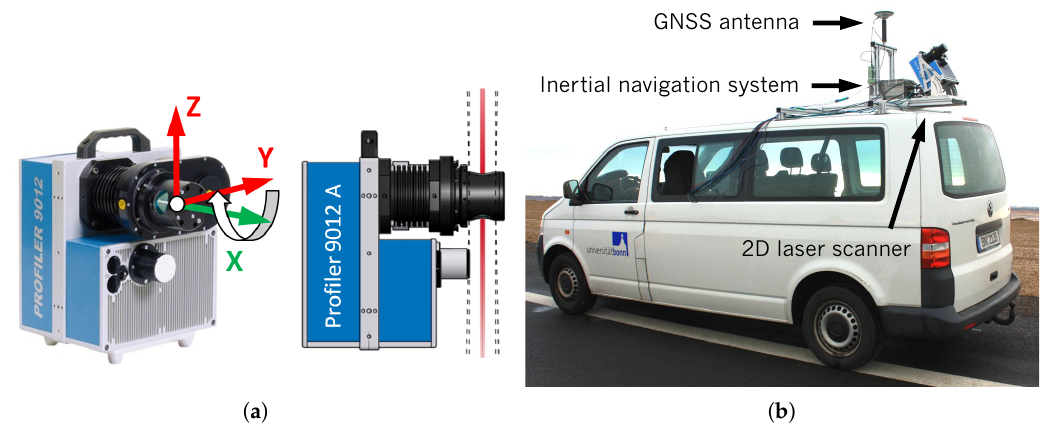
Figure 1. ( a ) Z + F Profiler 9012A with 2D scanning profile in red (YZ-plane) and rotational axis of the deflecting mirror in green (X-axis) [27]; ( b ) kinematic laser scanning system [45] equipped with the Z + F Profiler 9012A and an inertial navigation system iMAR iNAV-FJI-LSURV